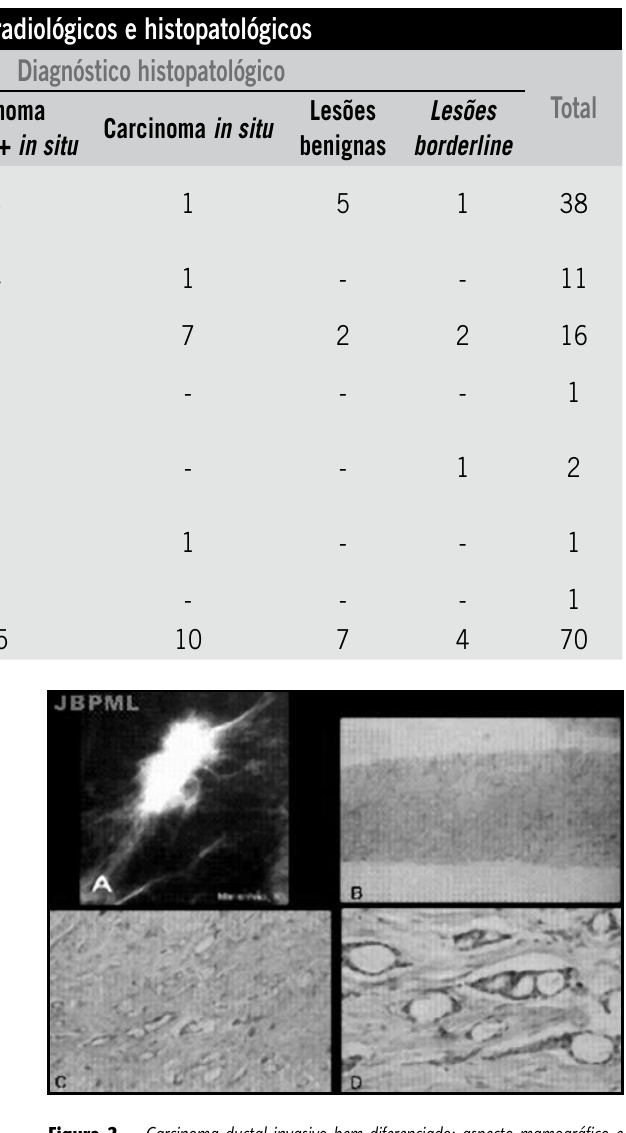
Figura 2 – Carcinoma ductal invasivo bem diferenciado: aspecto mamográfico e core biopsy. (A) Mamografia: nódulo irregular, espiculado; (B) core biopsy : carcino- ma ductal invasivo bem diferenciado (HE, 25X); (C) core biopsy (HE, 45X); (D) core biopsy (HE, 400X) Figura 1 – Microcalcificações: mamografia e core biopsy. (A) Mamografia: microcal- cificações pleomórficas finas; (B) radiografia dos fragmentos obtidos mostrando inclusão das microcalcificações na amostra (imagem superposta); a core biopsy mostra CDIS padrão sólido e comedônico com microcalcificações (HE, 100X); (C) peça cirúrgica correspondente, mostrando CDIS de mesmo padrão (HE, Valor preditivo dos diagnósticos mamográficos comparados ao diagnóstico histopatológico de